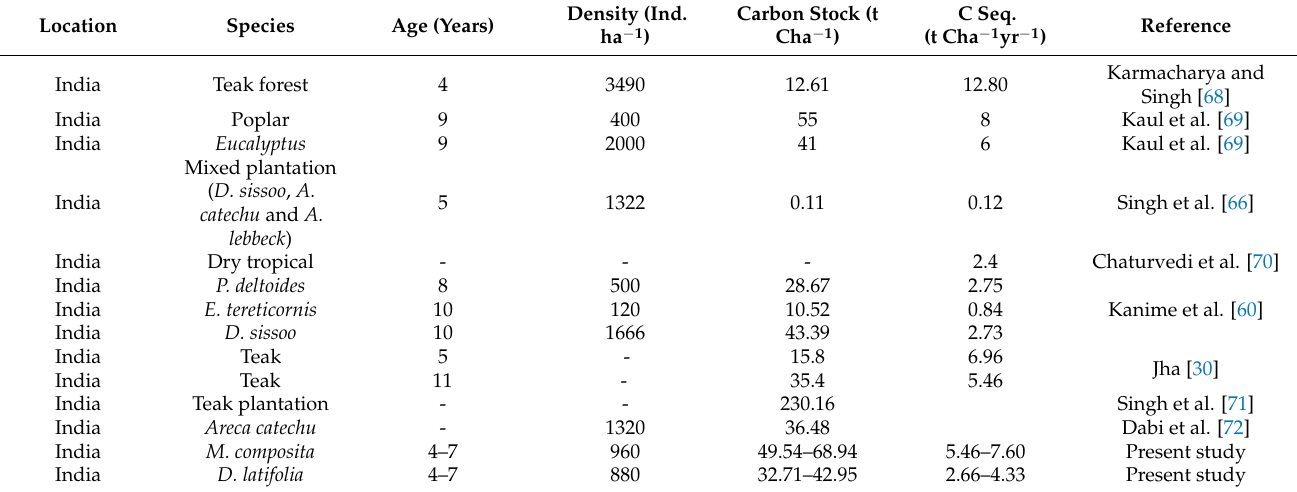
Table 10. Comparisons of carbon stock and carbon sequestration of different plantations in India.